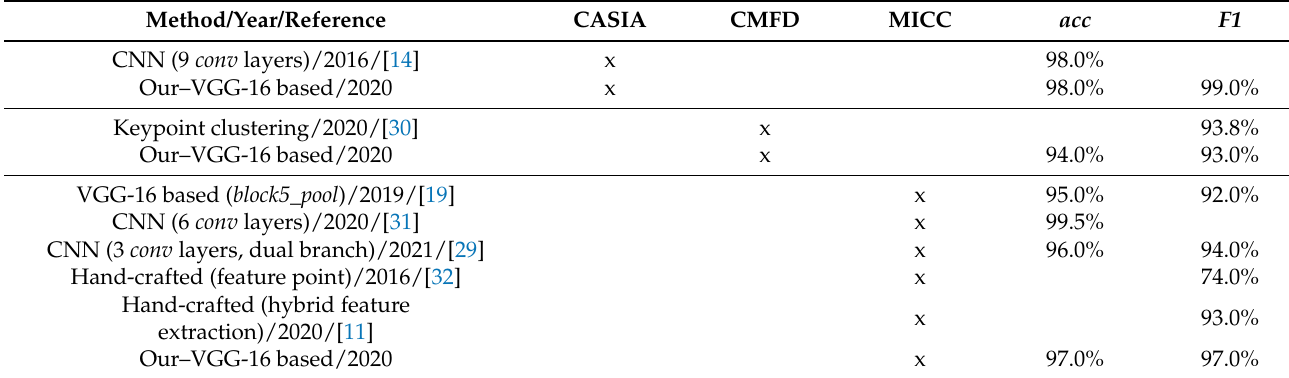
Table 6. Comparison between state-of-the-art approaches in terms of accuracy (acc) and F1 score for the datasets: CASIA (v1, v2), CMFD and MICC (F2000, F220, F600). The higher the